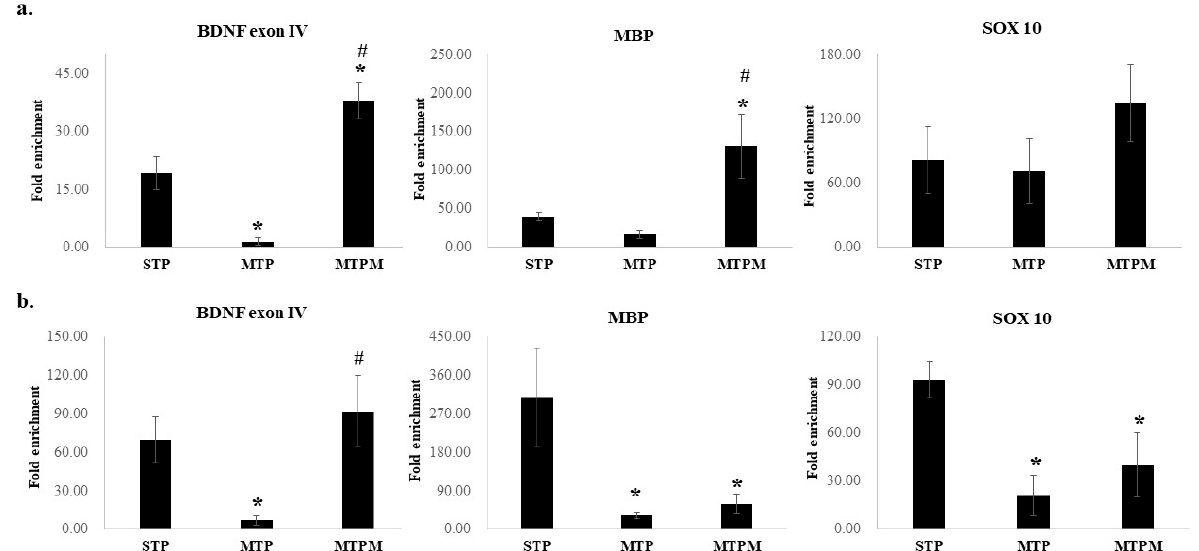
Figure 6. RPMT 1 regulated BDNF exon IV and myelination-related transcriptomes were repressed by MTX treatment while melatonin restored it. ( a ) RIP exam found significant decrease of BDNF exon IV and decrease of MBP and SOX 10 promoter in brain cortex. ( b ) RIP exam found significant decrease of BDNF exon IV, MBP, and SOX 10 in hippocampus. (* p < 0.05 vs. STP; # p < 0.05 vs. MTP).